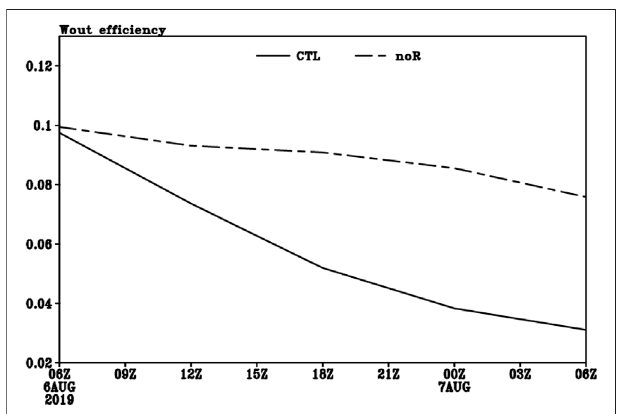
FIGURE 13 | The time evolution of the ratio of the work done in the out fl ow layer to the total net heat energy in CTL and noR.